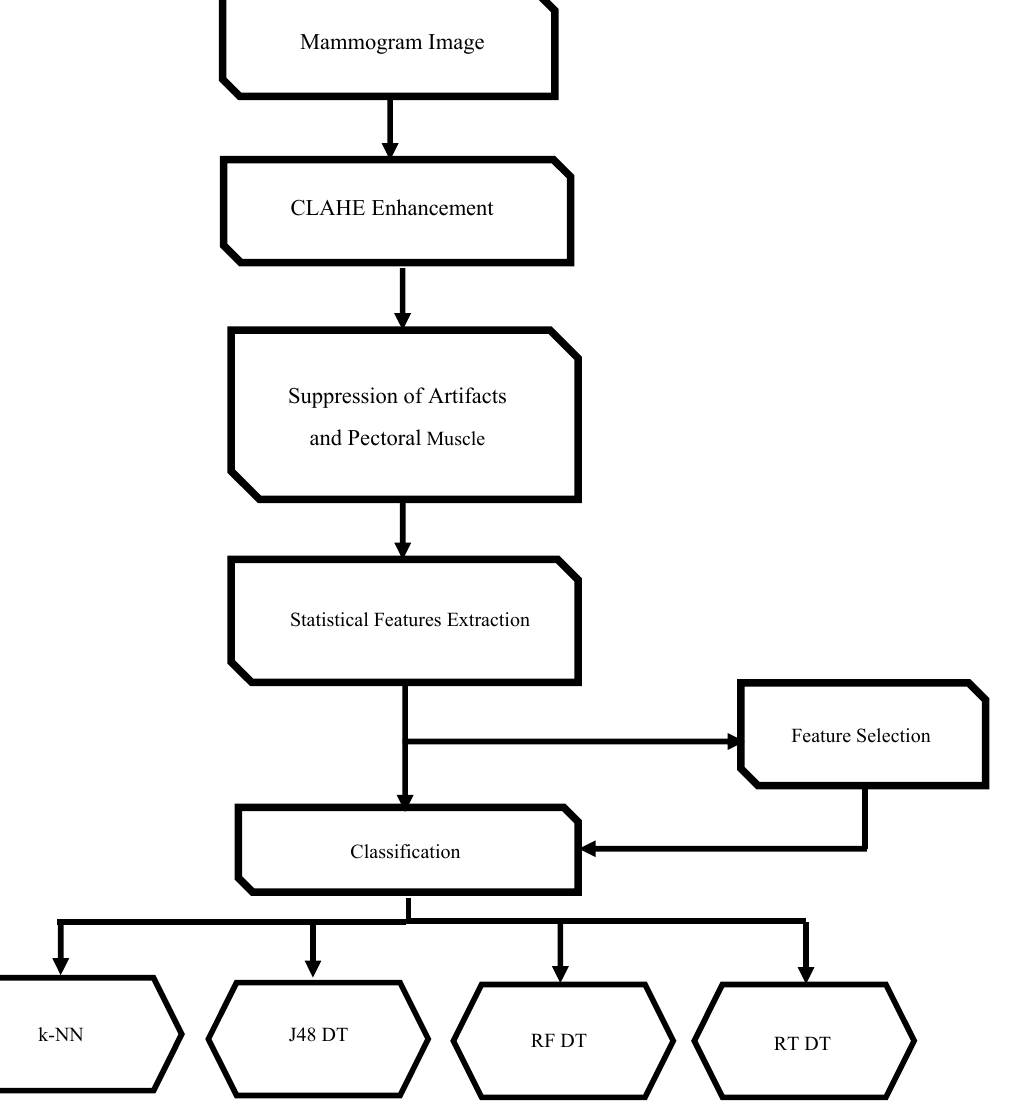
Figure 1. The block diagram of the computer-aided detection (CAD) system used.